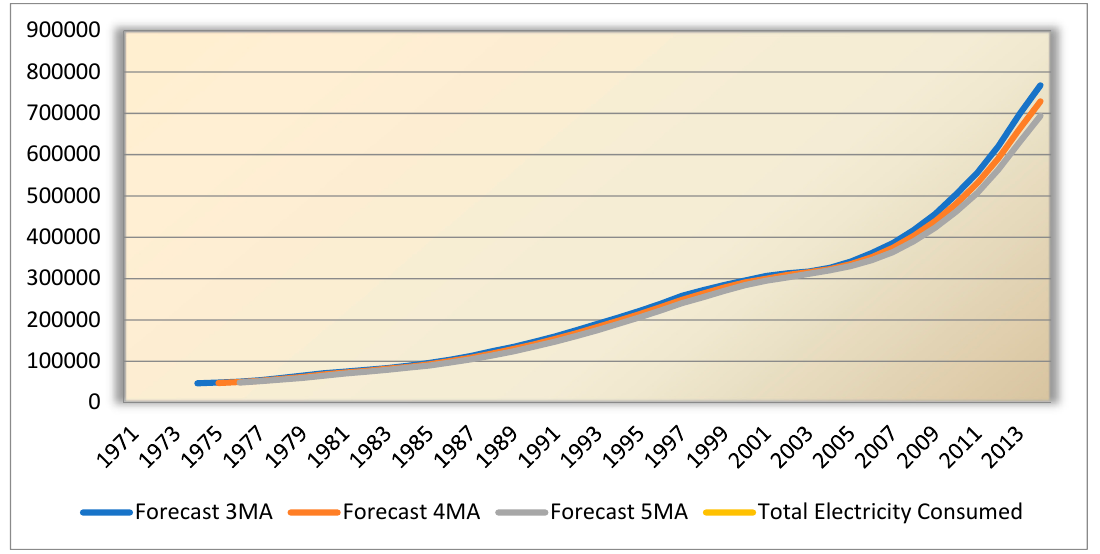
Figure 9. Chart for moving average method (1971–2014). Figure 10. Chart for Weighted moving average method